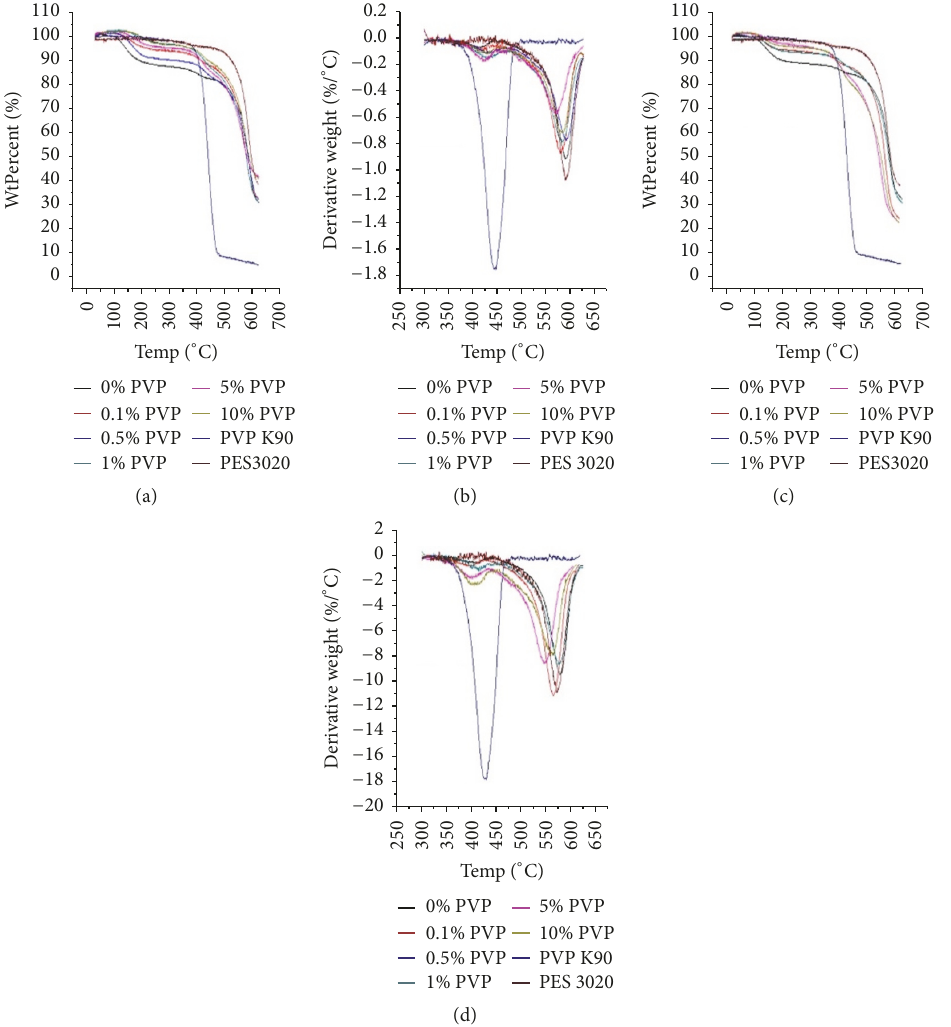
Figure 11: TGA and DTG spectra of PES/C (a-b) and PES/N membranes (c-d). Note: TGA, thermogravimetric analysis; DTG, differential